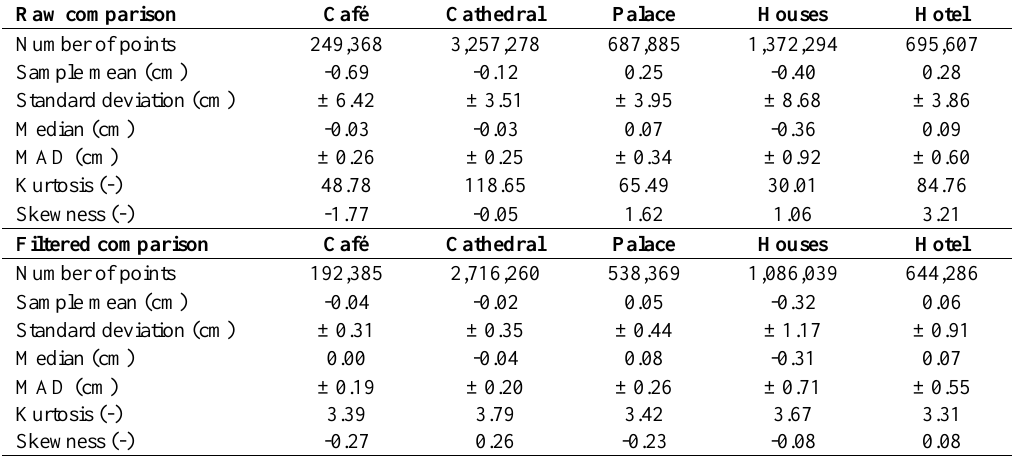
Table 3. Statistical results of the accuracy evaluation: MMS vs. Photogrammetry comparisons on the raw and filtered point